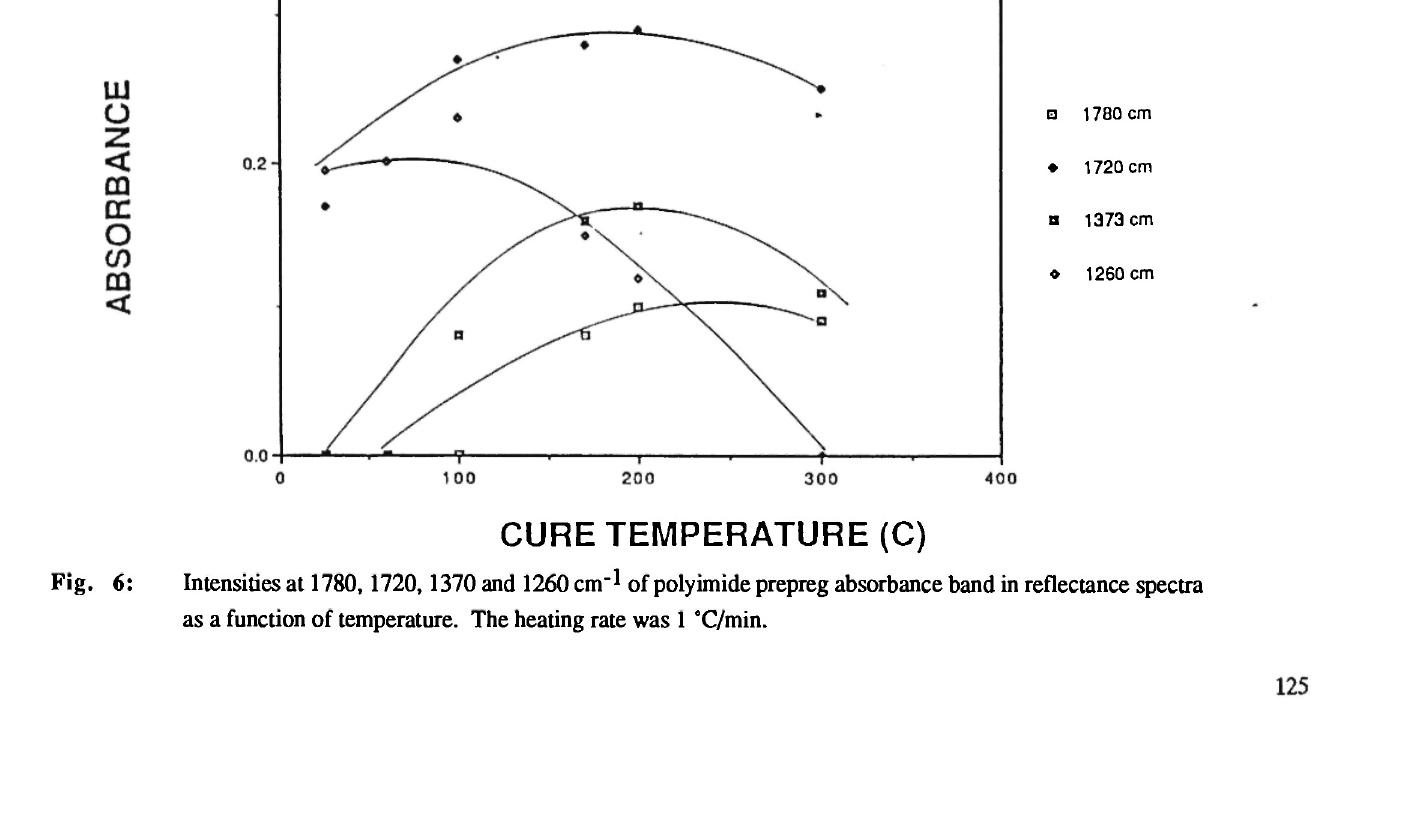
Cure Temperature(°C) Fig. 5: Intensities at 1780,1720,1370 and 1260 cm' 1 of neat resin absorbance band in transmission spectra as a function of temperature. The heating rate was 1 5 C/min.